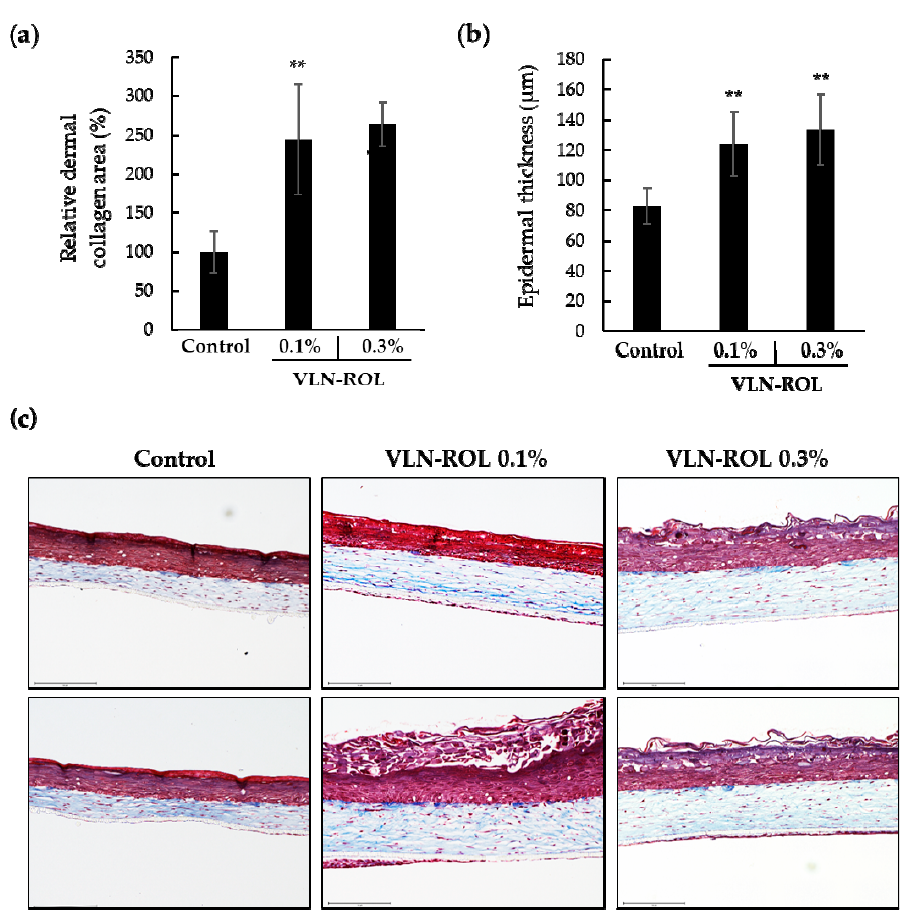
Figure 4. Effects of VLN-ROL on the three-dimensional (3D) human skin model. VLN-ROL was added at different concentration (0.1, 0.3%) on the top of the 3D human skin model and cultured after 48 h. ( a ) Relative dermal collagen area stained by Masson’s trichrome staining and ( b ) epidermal thickness measured with the Celleste™ Image Analysis Software. ( c ) Sectioned 3D human skin images after Masson’s trichrome staining. The upper red color region shows the epidermis area and the lower blue color region shows the dermis area ** p < 0.01 indicate significant differences compared with control).